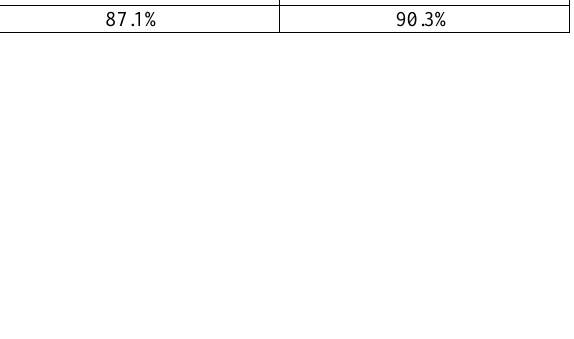
Table 1. The percentage of correctly matched pixels of the implemented semi-global dense matching (SGM) before and after applying the proposed refinement SGM SGM + Refinement 90.3%